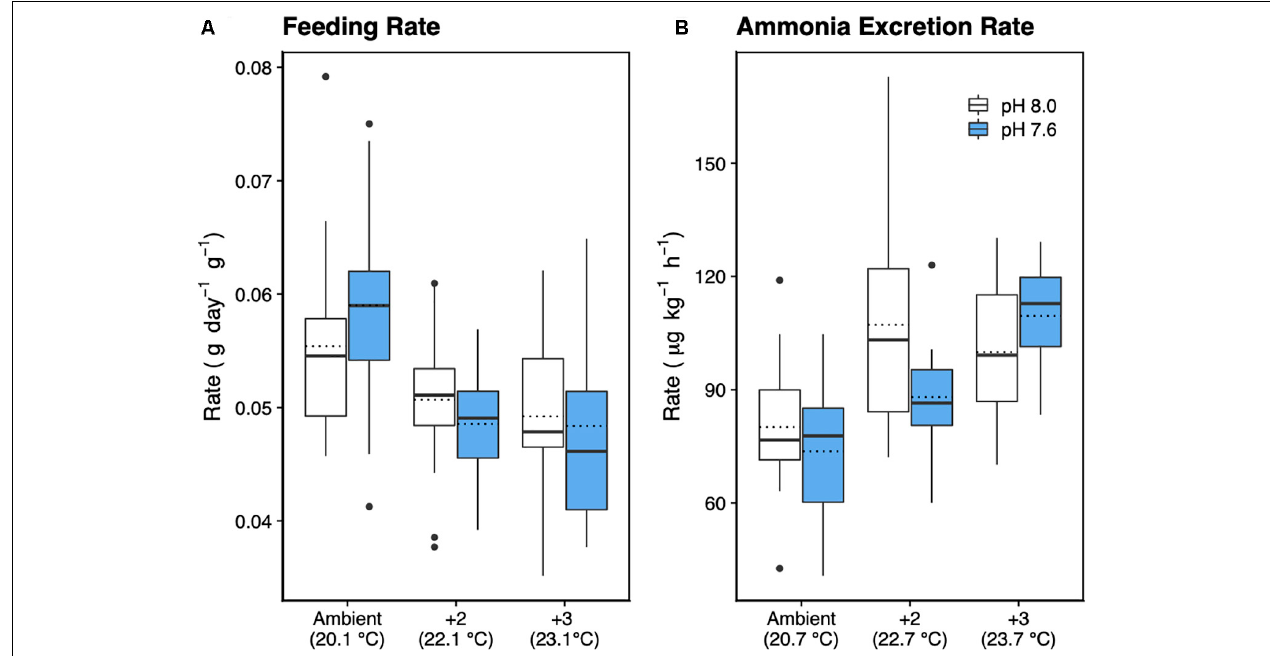
FIGURE 4 | Feeding rate in dry food weight (A) and (B) ammonia (NH 3 ) excretion rate of H. erythrogramma acclimated for 12 weeks in three temperature (ambient, +2 ◦ C, +3 ◦ C) and two pH T (white: 8.0, blue: 7.6) levels in six treatments. The top and bottom of the boxes represent the interquartile range (IQR) between the 25th and 75th percentile (Q1 and Q3, respectively). The horizontal line represents the median (Q2), the horizontal dotted line represents the mean, and the vertical lines (whiskers) represent the range of the data computed as follows: Q1 – 1.5 IQR (bottom whisker); greater than Q3 + 1.5 IQR (top whisker).